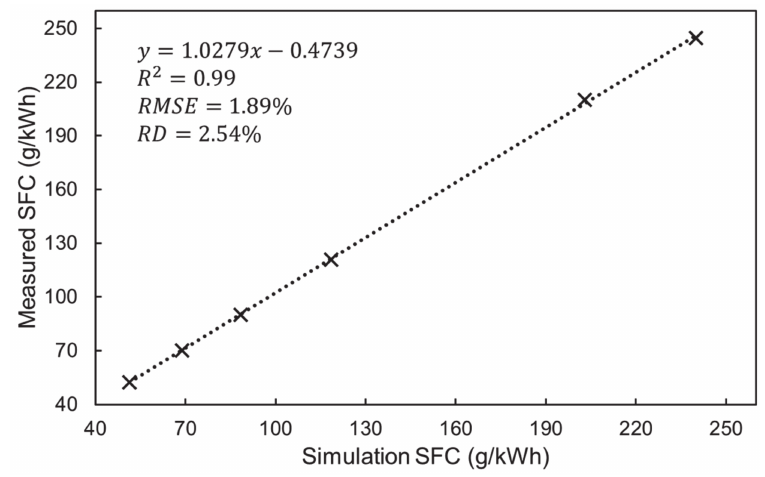
Figure 10. The linear regression of the average simulation and measured SFC.